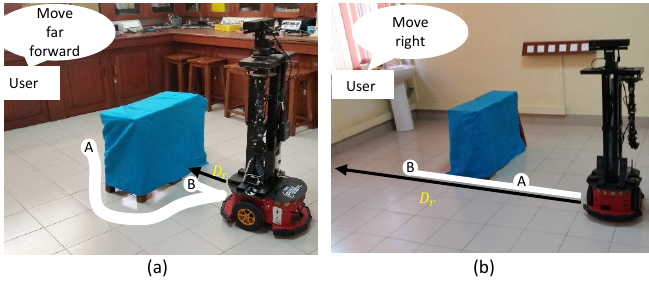
Figure 3. ( a , b ) show two example situations that exhibit the limitations of the method explained in [20]. The position requested by the user may be either positions ‘A’ or ‘B’. However, the existing system considers only position ‘B’. It should be noted that the annotated positions and paths are not exactly those generated from the systems and these are marked for the sake of